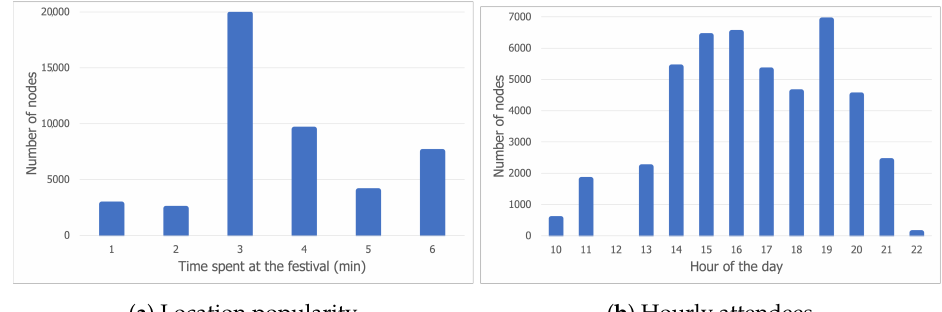
Figure 2. Location popularity and hourly attendees for day 1 of the Sonar